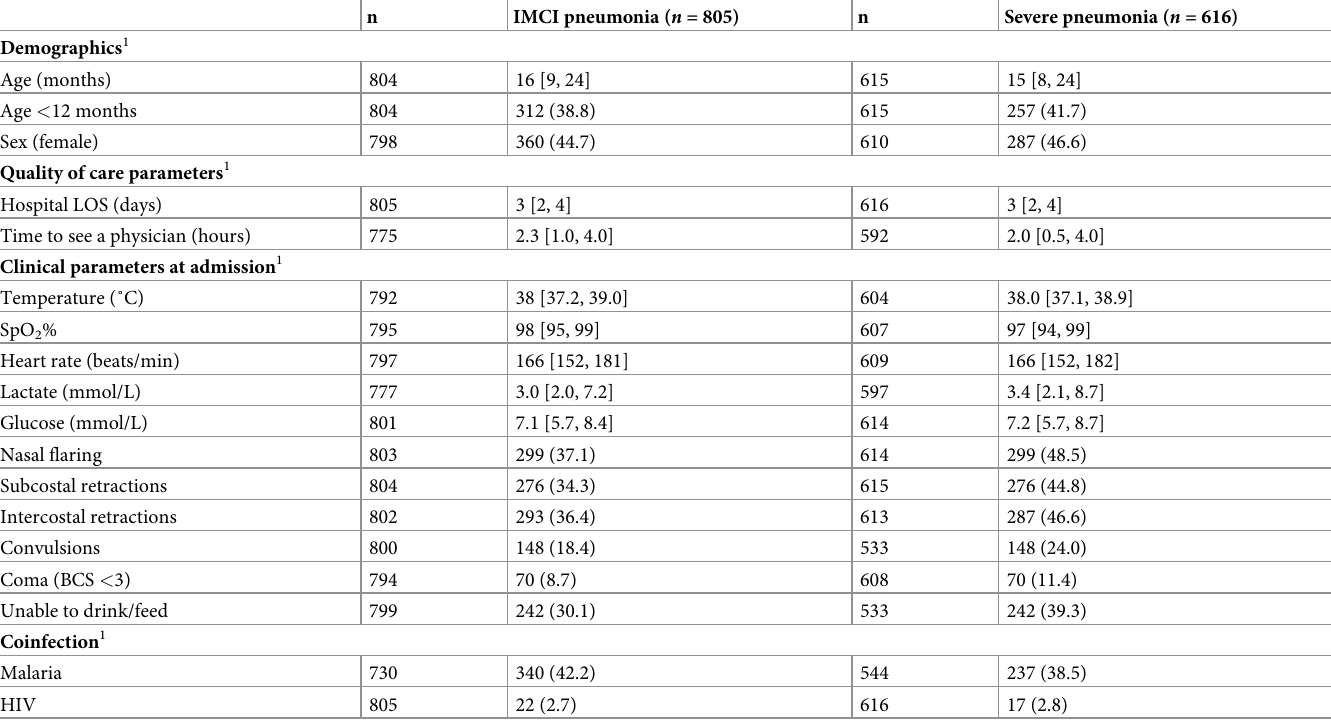
Table 1. Patient